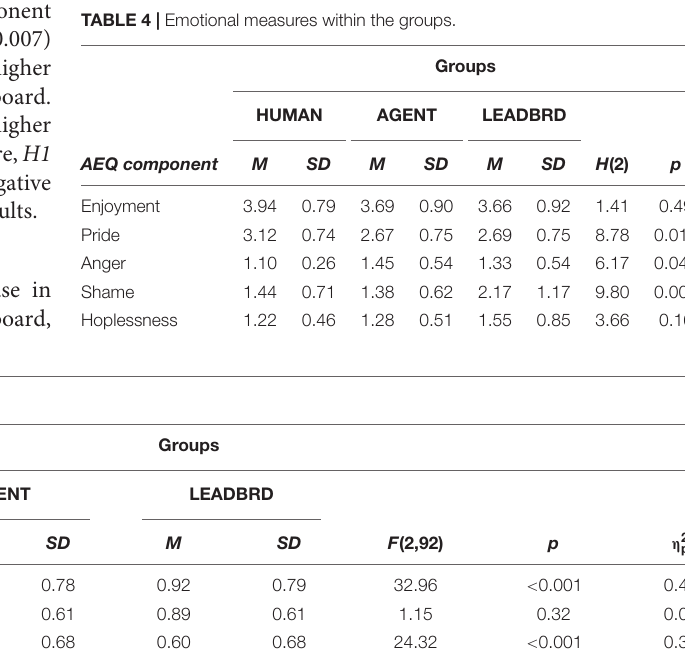
TABLE 4 | Emotional measures within the groups.